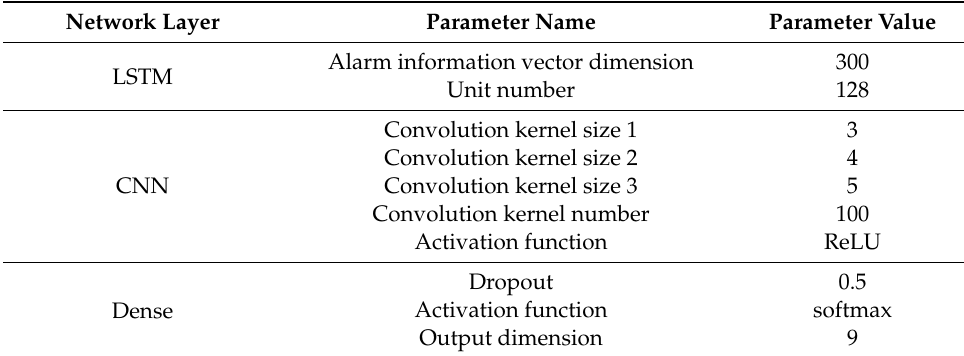
Table 4. Parameters of combined model LSTM-CNN.